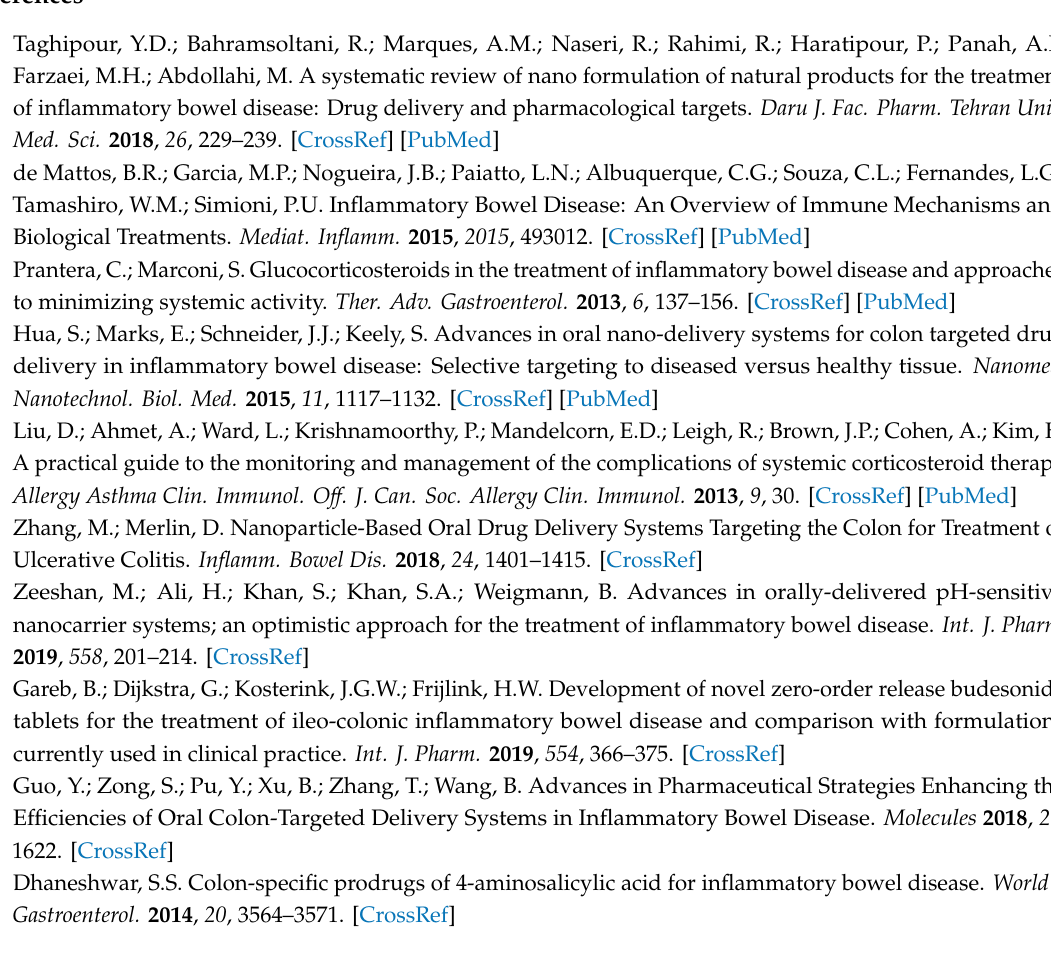
Figure S1: FT–IR spectra of: B raw material, blank F3 and B loaded